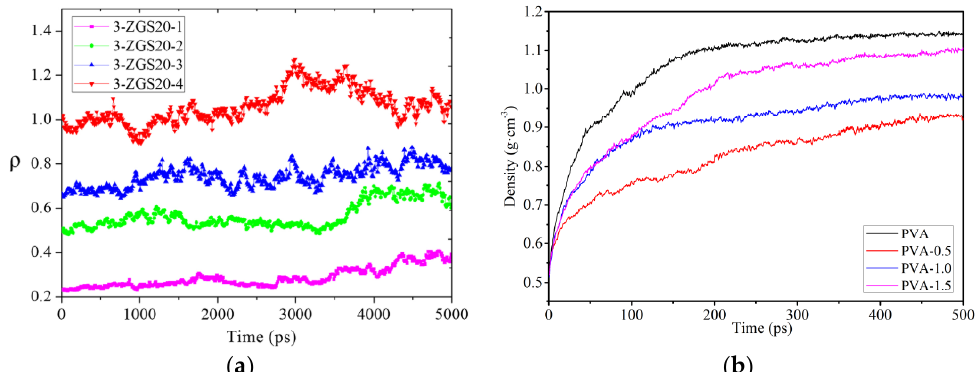
Figure 8. The construct procedure of PEBA chains and membranes [56].